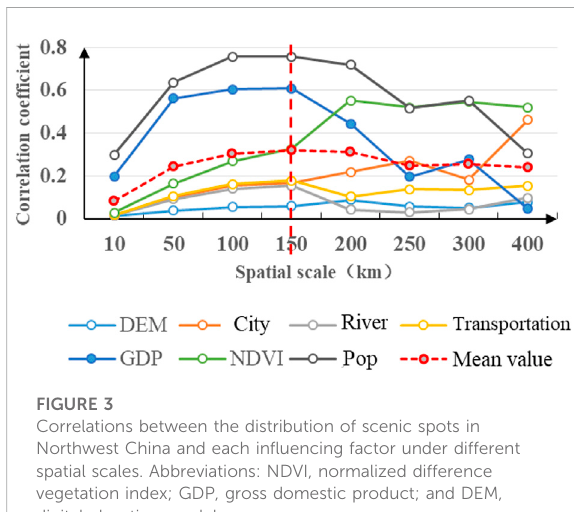
FIGURE 3 Correlations between the distribution of scenic spots in Northwest China and each in fl uencing factor under different spatial scales. Abbreviations: NDVI, normalized difference vegetation index; GDP, gross domestic product; and DEM, digital elevation